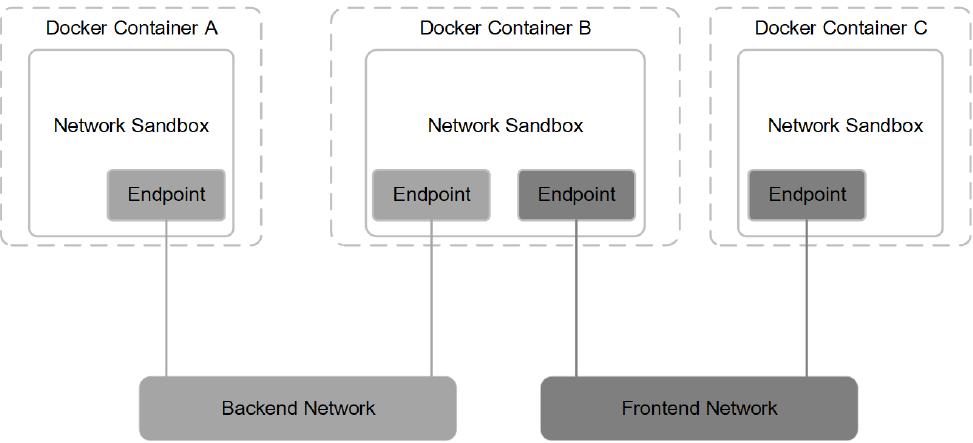
Figure 2. Container network model showing the back-end and front-end